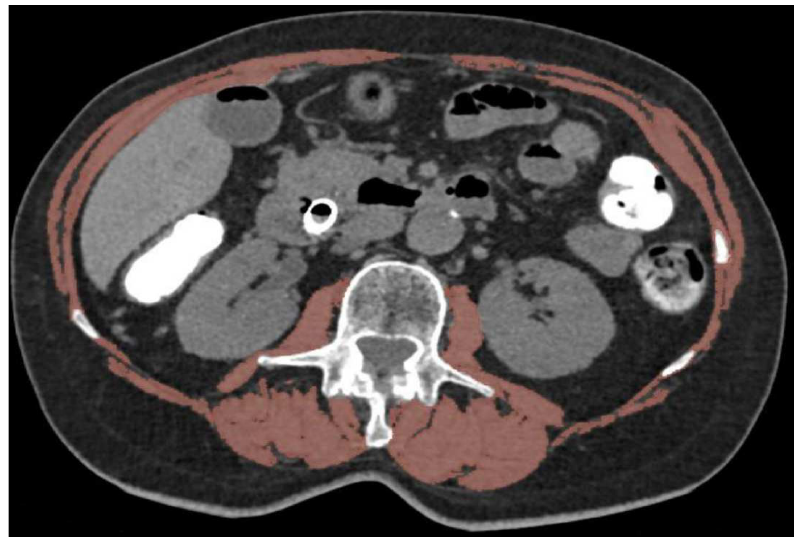
Figure 1. CT image in the axial plane shows segmented muscles in a sarcopenic patient (body mass index = 24 kg/m 2 ). Muscle structures forming the cross-section areas used to calculate skeletal muscle index are displayed in orange.